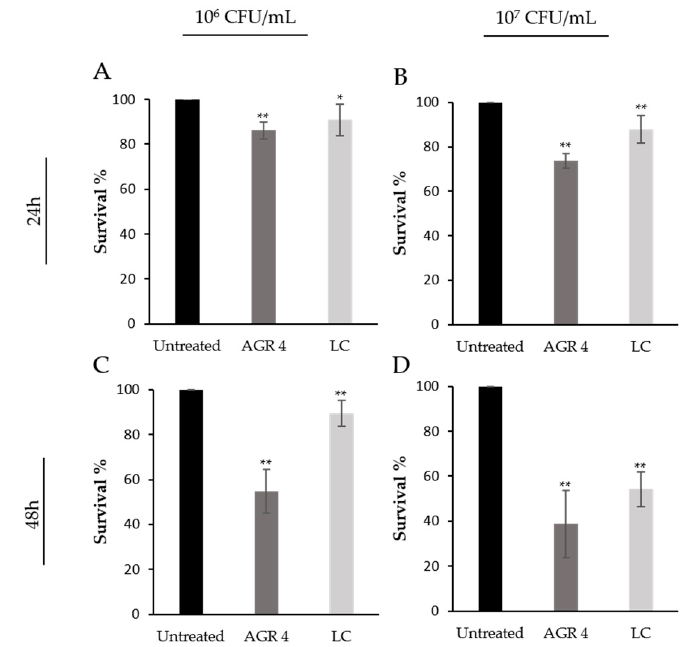
Figure 4. Time- and dose-dependent antiproliferative effects of viable Lactobacillus AGR 4 against the human adenocarcinoma cell line, HT-29, as determined by SRB assay. HT-29 cells were incubated with 10 6 CFU/mL ( A , C ) or 10 7 CFU/mL ( B , D ) of Lactobacillus AGR 4 for 24 ( A , B ) and 48 h ( C , D ). Lactobacillus casei (LC) ATCC 393 was included in the study as a reference strain. Data is presented as the mean ± standard deviation of three independent experiments. * p < 0.05; ** p < 0.01 compared to untreated cells.